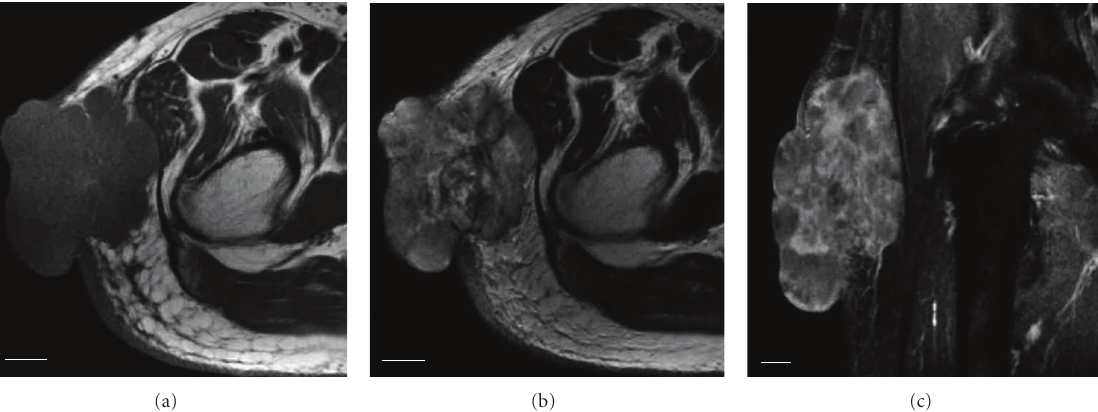
Figure 2: MR images of the tumor in the pre-treatment condition. (a) Axial T1-weighted image. (b) Axial T2-weighted image. (c) Coronal STIR sequence enhanced with Gd-DTPA. Bars = 2cm. The heterogeneous mass was attached to the fascia lata and expanded across the skin layer.